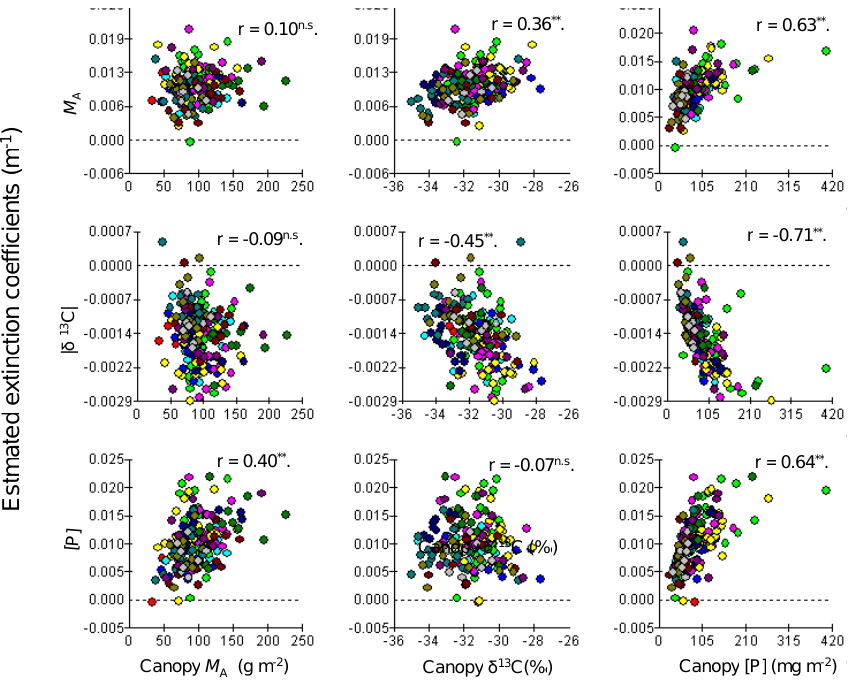
Fig. 9. Relationship between within canopy gradients in leaf mass per unit area ( M A ), foliar δ 13 C and leaf phosphorus concentrations (area basis) and the overall mean M A δ 13 C and [P] A in the same tree. Also shown are Spearman’s rank correlation coefficients and their level of significance (*; P< 0.05; **; P< 0.01). Different colours refer to different